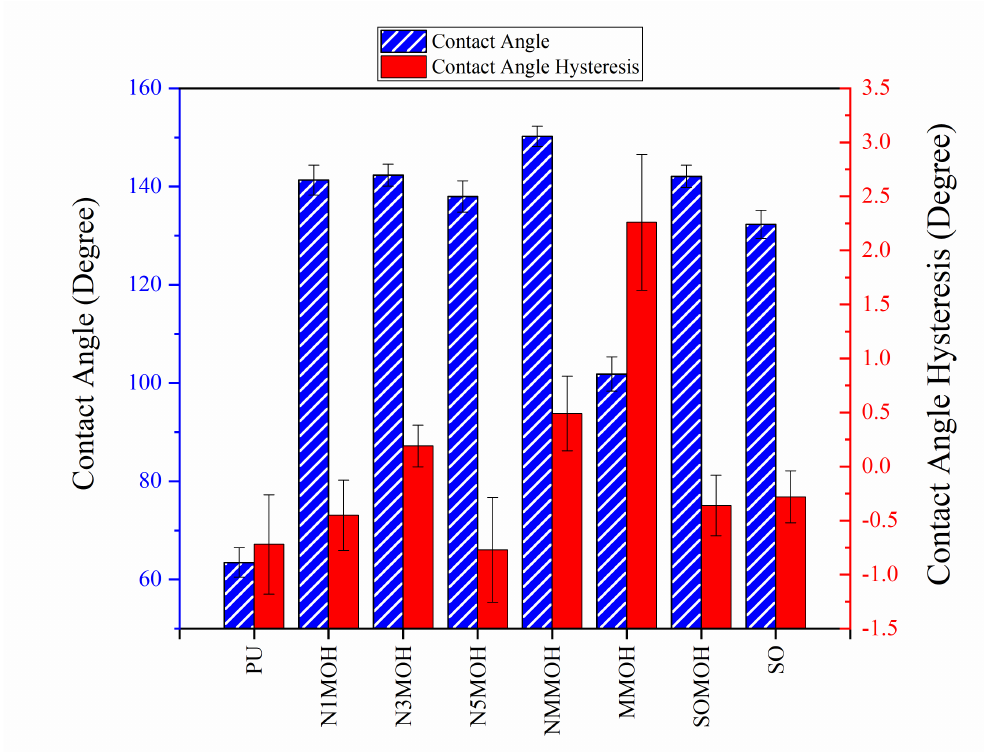
Figure 5. Alterations in the hydrophobicity of the PU composites. The hydrophobicity increased if the filler added to the matrix resulted in a uniform and favorable surface roughness in the